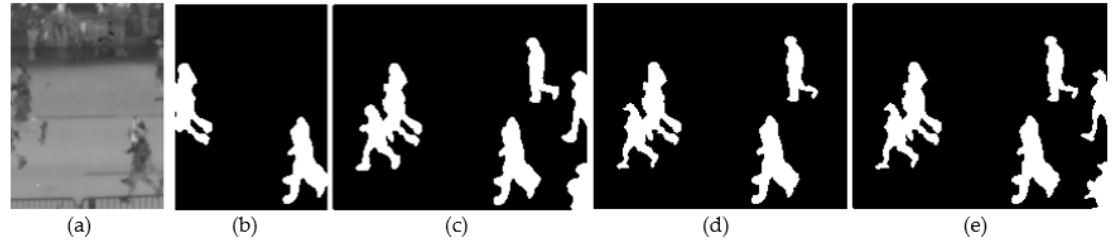
Figure 16. Comparisons of detection results using original images, GT images, and the predicted images obtained by the state-of-the-art methods and the proposed method: ( a ) original images; detection results using ( b ) original images and ( c ) GT images of Figures 11b, 12b and 13b; and the images predicted by ( d ) pred3-chan [14] and ( e ) the proposed method.